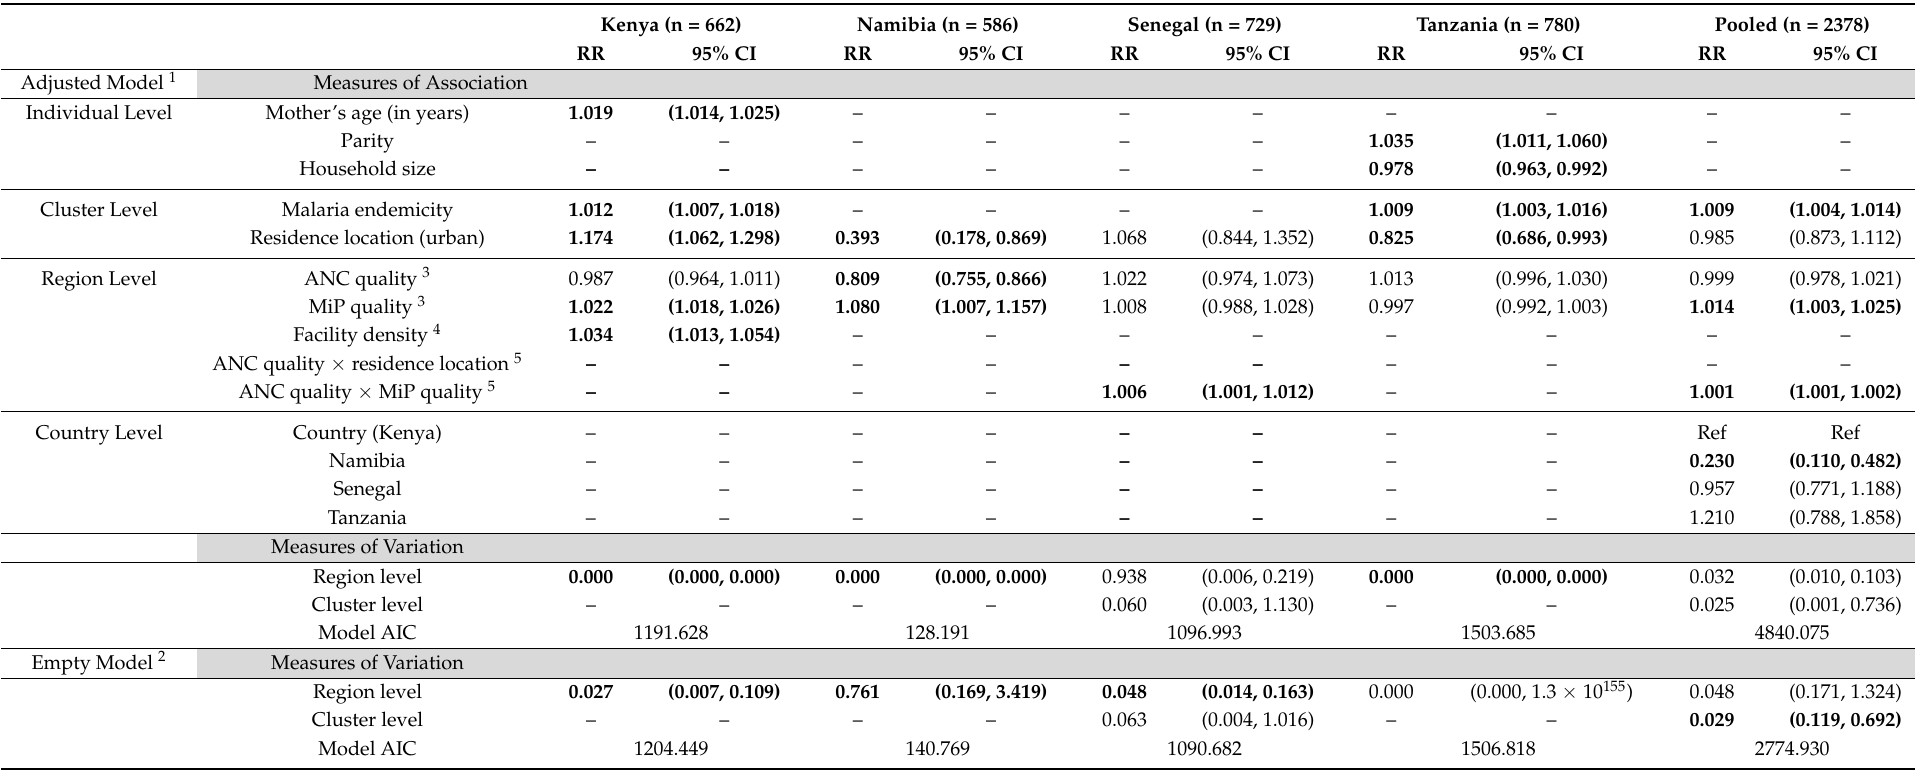
Table 4. Adjusted multilevel mixed effects modified Poisson results for insecticide-treated net use in